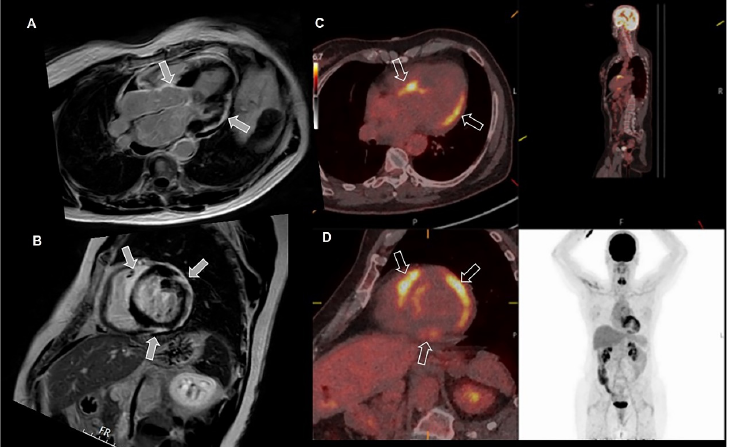
Figure 7. Cardiac sarcoidosis diagnosed with cardiac magnetic resonance (CMR), positron emis- sion tomography (PET) and computed tomography (CT). The figure shows the presence of subep- icardial late gadolinium enhancement inferior and lateral, and midmyocardial in the basal interven- tricular septum (arrows), suspicious for sarcoidosis on CMR ( A , B ). PET-CT images ( C , D ) show cor- responding increased uptake (arrows) of fluorodeoxyglucose, indicating inflammatory lesions as- sociated with sarcoid activity in the corresponding areas, enabling the diagnosis of sarcoidosis. Note the absence of tracer uptake outside the heart indicating isolated cardiac sarcoidosis.